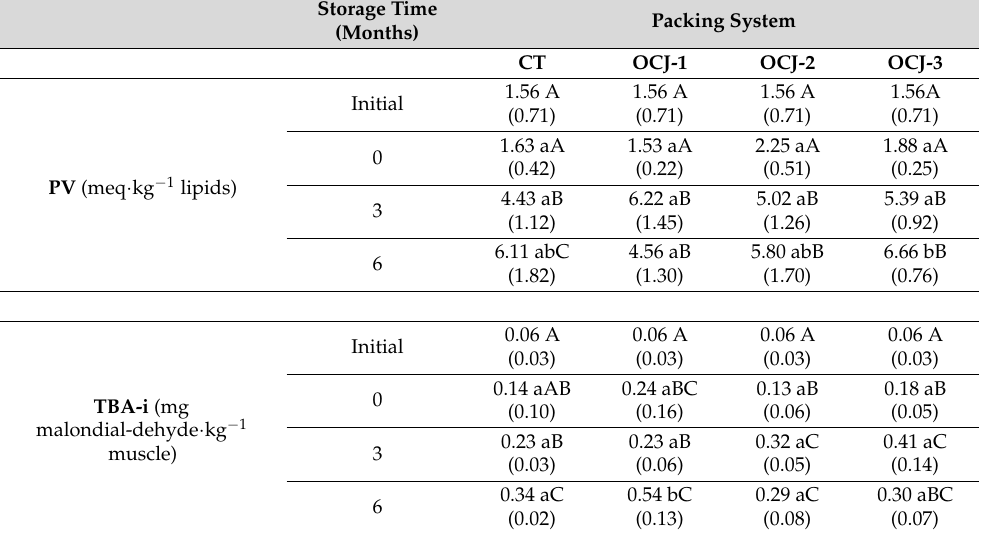
Table 1. Determination * of primary and secondary lipid oxidation in initial and canned horse mackerel previously subjected to frozen storage and canned with different packing systems